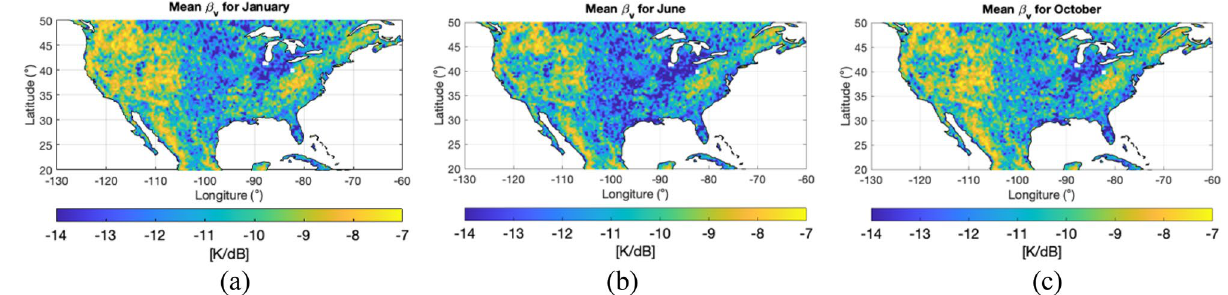
′ Figure 8. Monthly β obtained for three different months over the CONUS region: ( a ) January, ( b ) June and ( c